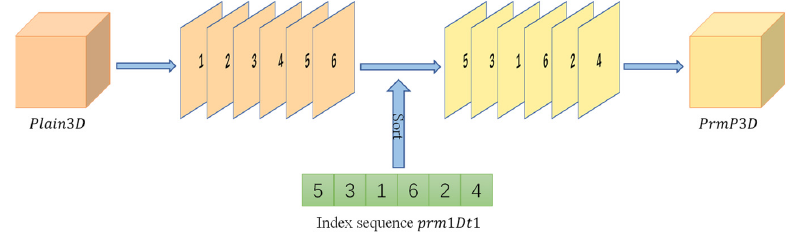
Figure 6. Interlayer scrambling of image cuboids.